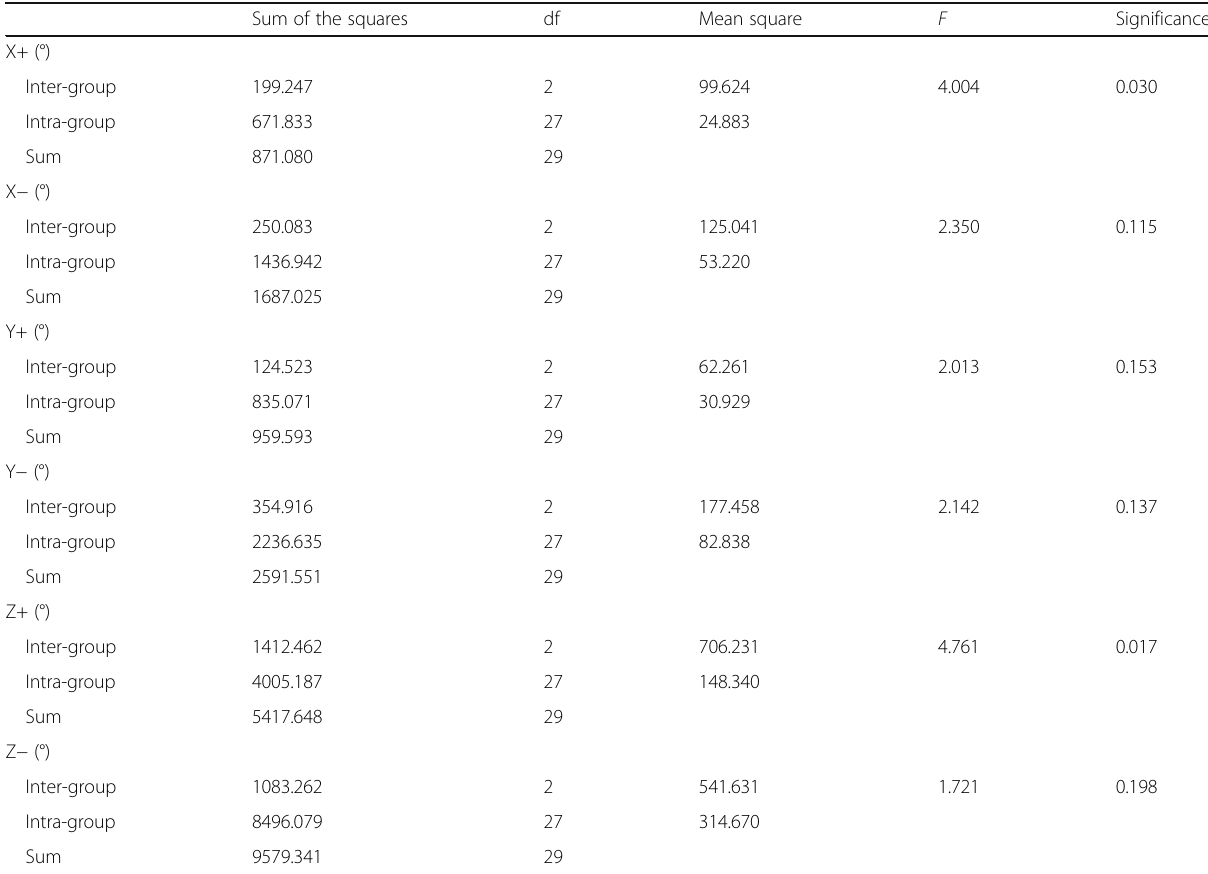
Table 3 Variance analysis of virtual avatar motion